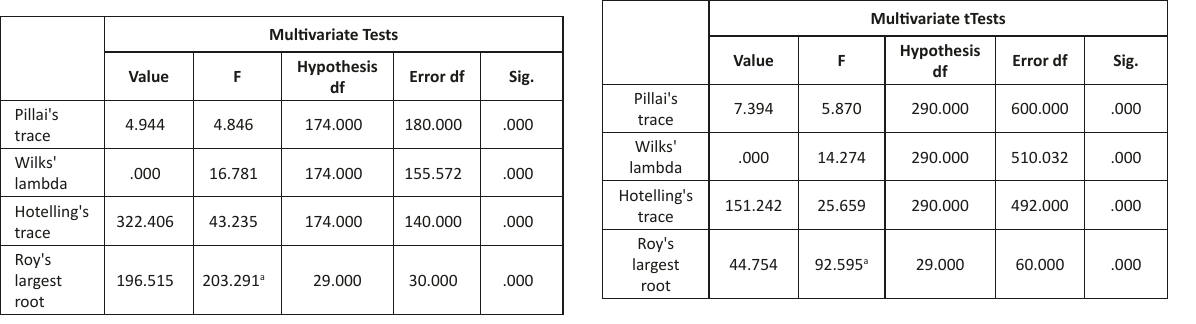
Table 7. MANOVA for Tetraodontidae from southeastern